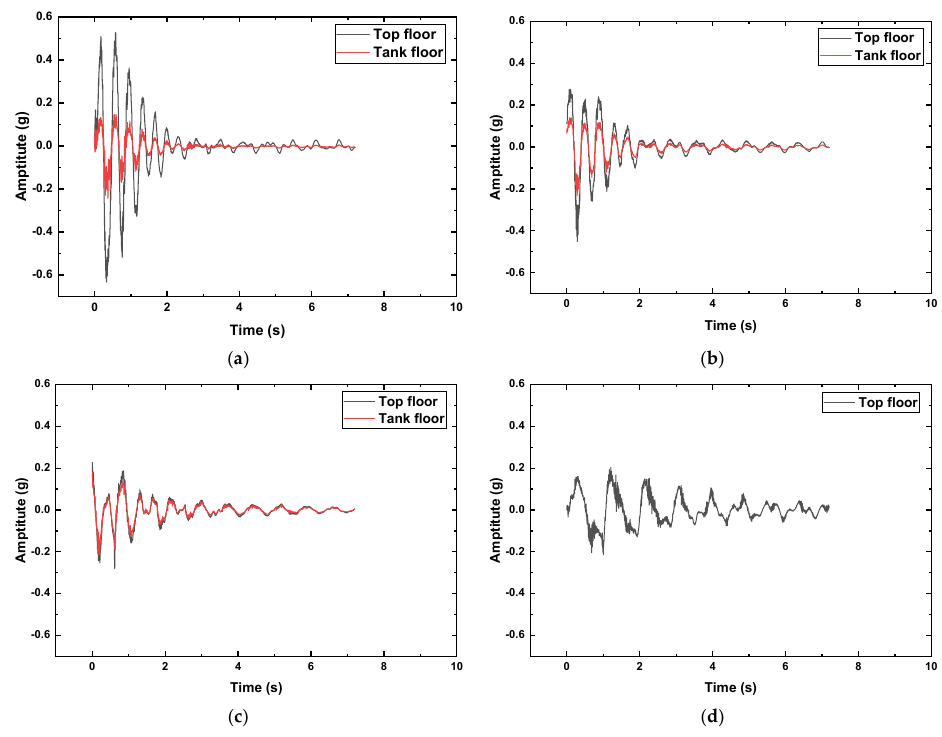
Figure 7. The accelerations when the water tank with a water level of 6 cm is placed on each floor of the structure. ( a ) 2nd floor; ( b ) 3rd floor; ( c ) 4th floor; ( d ) 5th floor.